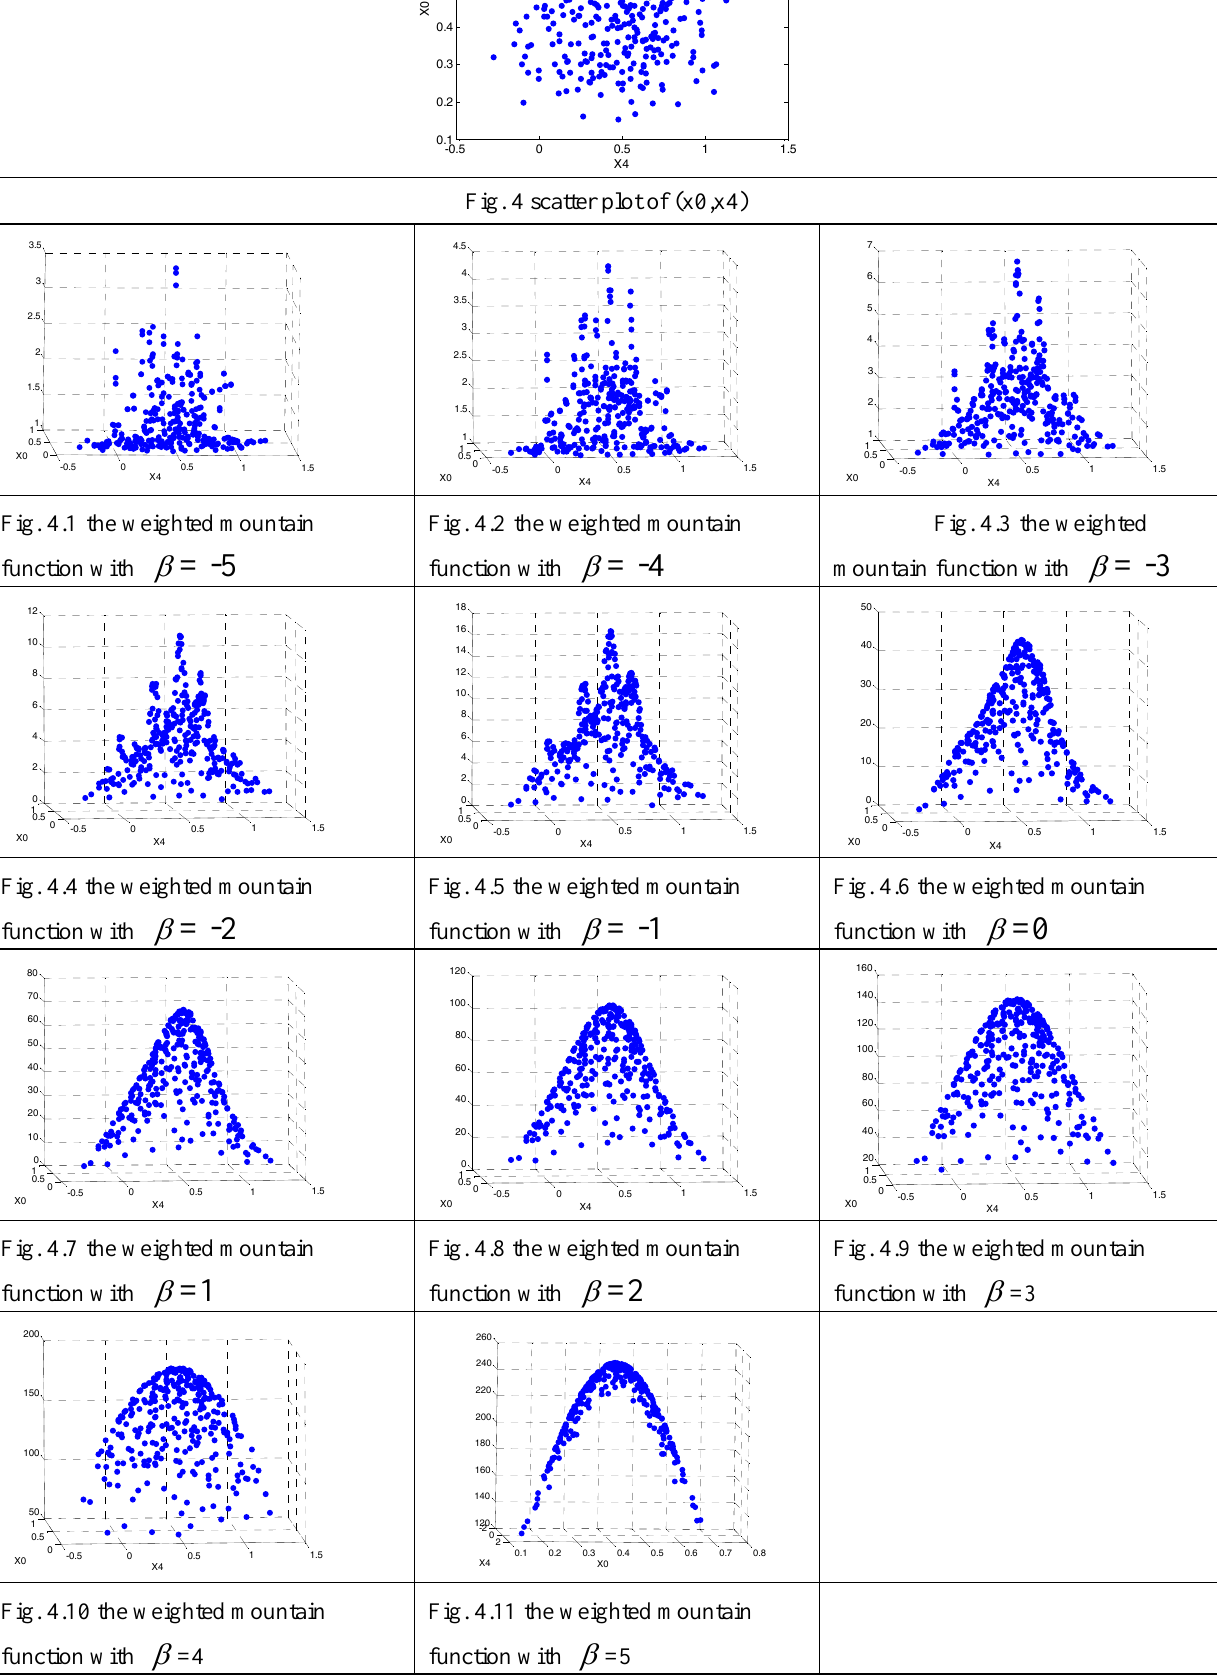
Fig. 4.10 the weighted mountain function with  =4